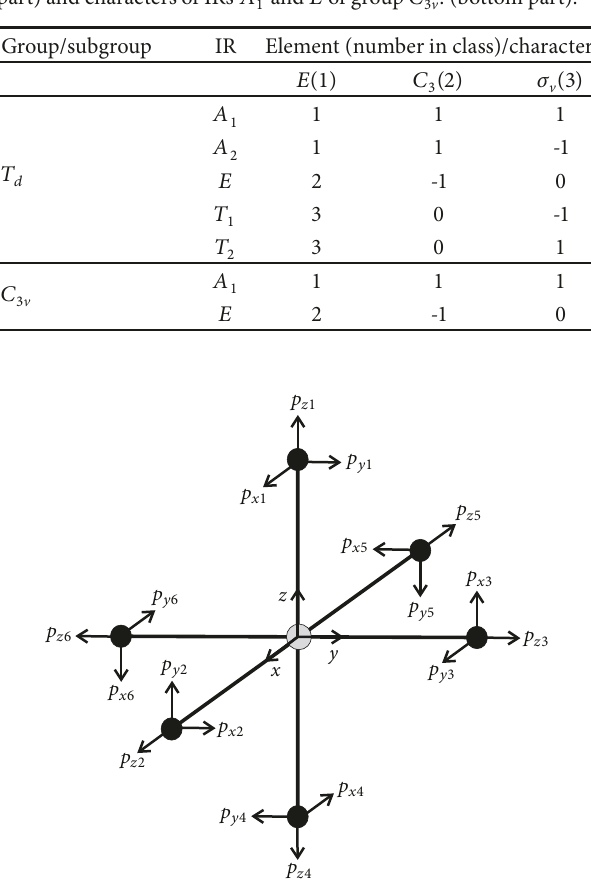
Figure 2: Basis set for SALC of atomic orbitals in octahedral